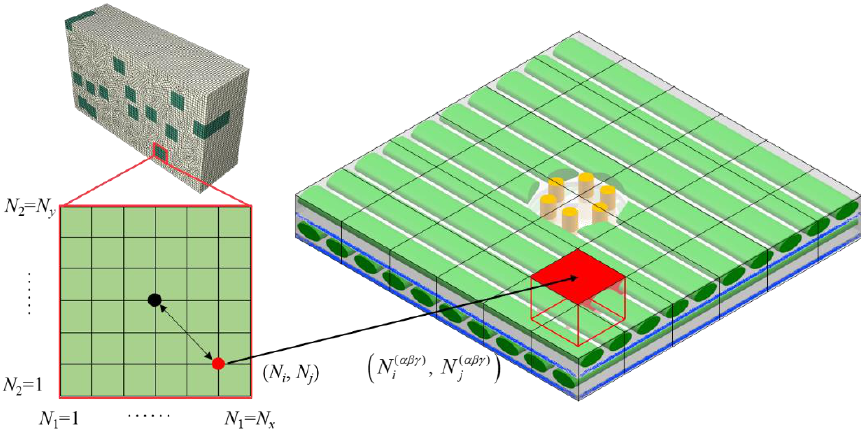
Figure 7. Local volume average of needling region mesoscopic damage.